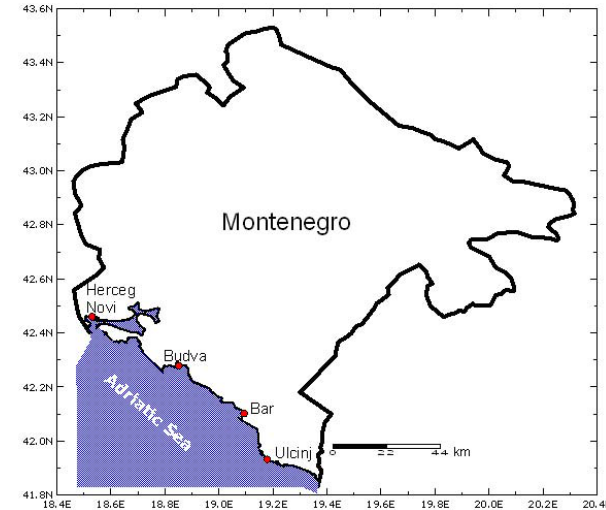
Fig. 1. Locations of the